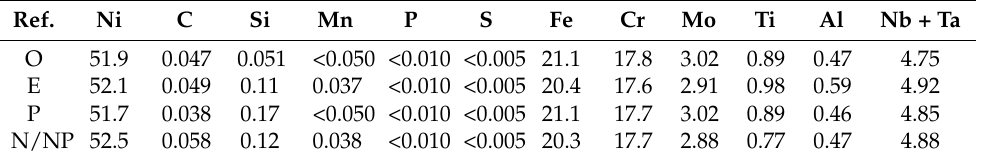
Table 1. Chemical composition of alloy 718 casting heats in weight percentage. Ref.